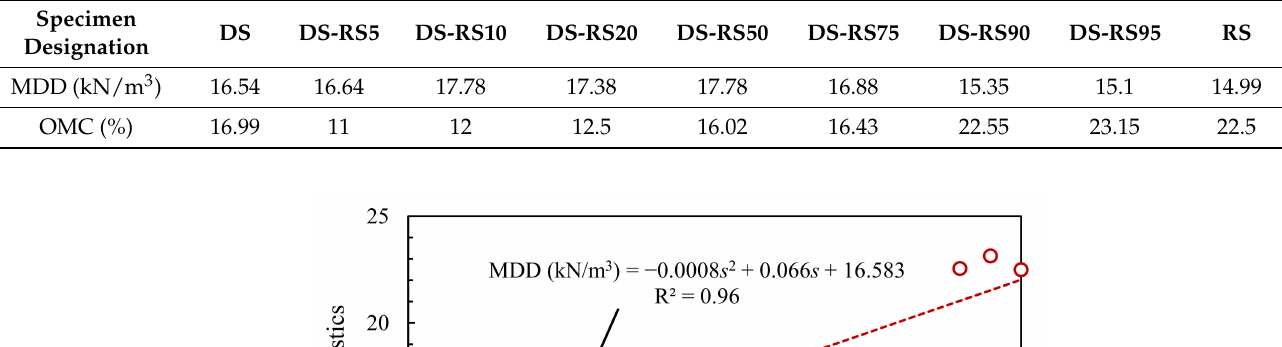
Figure 7. Moisture density relationships of the dune sand-sediment mixes. Table 3. Maximum dry density (MDD) and optimum moisture content (OMC) for each mixture.